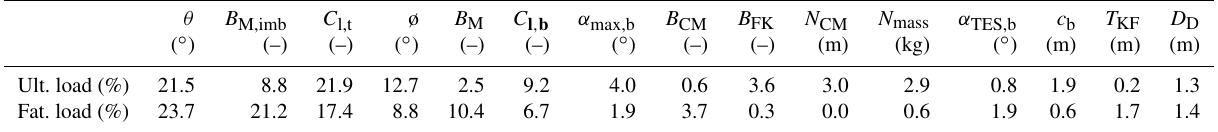
Figure 10. Sample original and perturbed C l and C d curves for each airfoil section used in the NREL 5MW reference turbine. Perturbed values represent ± 10% of the specified range for each parameter. Table 11. Percentage of contribution to total number of significant events for ultimate and fatigue